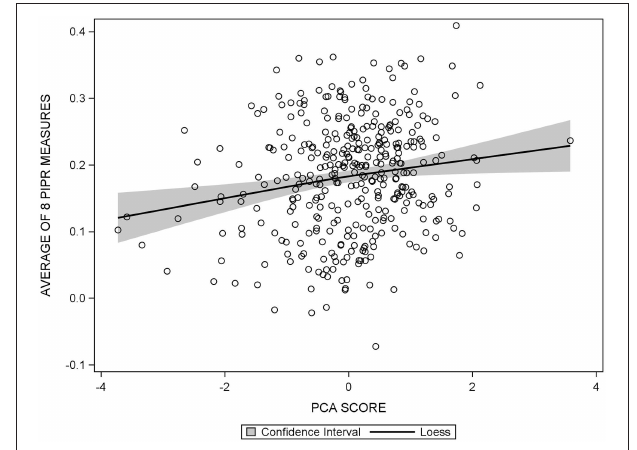
FIGURE 1 | An example of pupil recording. The percent pupil diameter relative to baseline was plotted against time to a 1-s red and blue stimulation at a stimulus intensity of 2.0 log lux (gray bar). The baseline pupil diameter was calculated as the average pupil diameter in millimeters over 5s immediately before the stimulus onset. The post-illumination pupil response (PIPR) (double arrow) was calculated as the difference of the pupil contraction amplitude relative to baseline pupil diameter (%) between the blue (blue) and red (red) light stimulation at 6s after termination of the 1-s light stimulus (The dashed line points the PIPR to 7s on the x-axis, which is 6s post stimulus-offset).